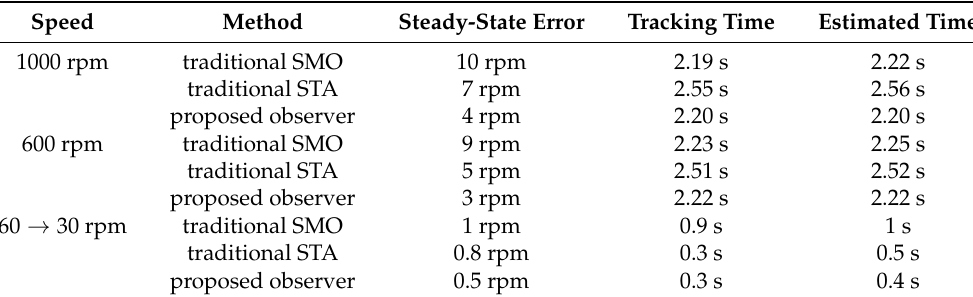
Figure 26. Experimental results under stepped load. Table 2. Comparison analysis of experimental